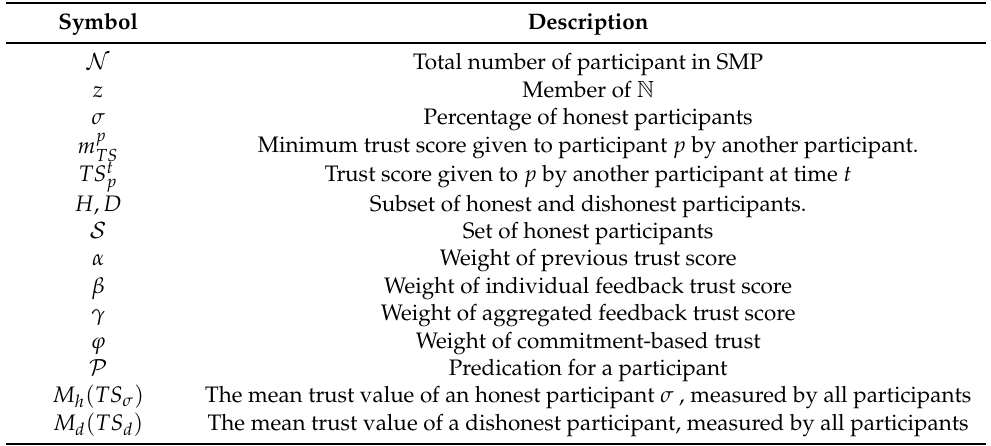
Table 1. Symbols with